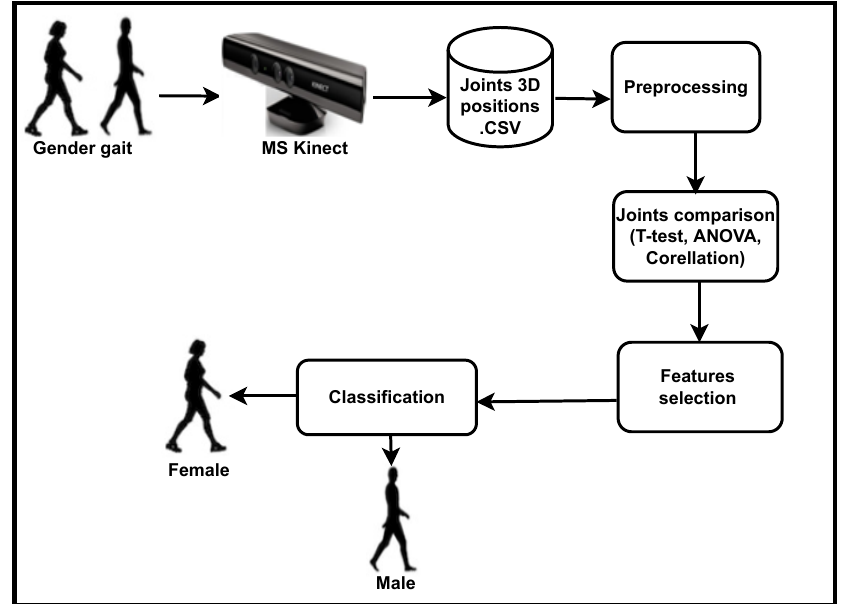
Figure 1. Detail model of the proposed